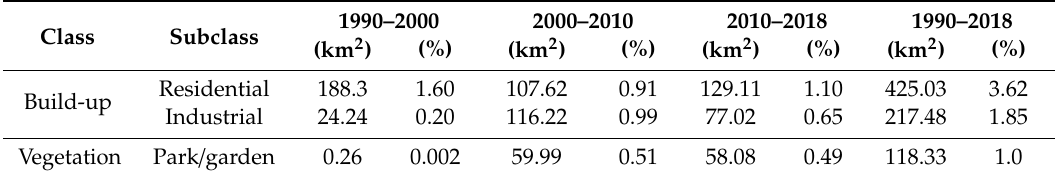
Figure 7. The overall change in the areas of built-up ( a ), and vegetation ( b ) from 1990 to 2018, and ( c ) population density of the NUAE. The red line separates the garden/ parks and farmlands. The population density measures the numbers of persons per square meter. These maps are draped over a DEM. Table 5. Estimates of LULC changes (in km 2 and percentage) from 1990 to